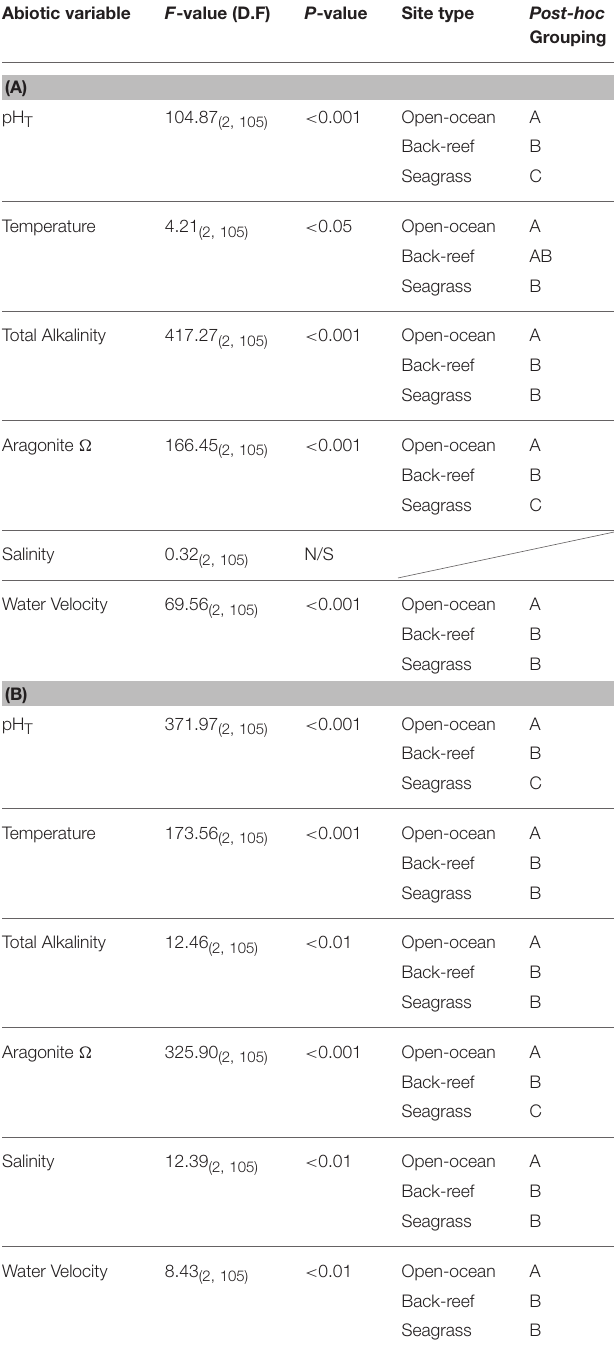
TABLE 2 | Statistical results for comparisons of abiotic variables among the back-reef and seagrass habitat types and relative to the open-ocean reference sites.